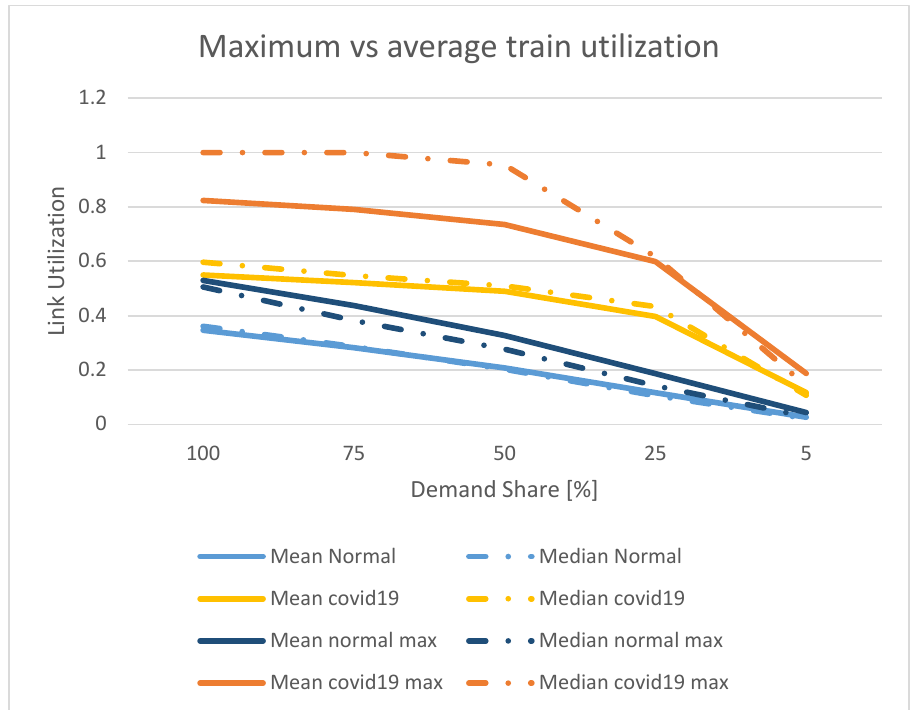
Figure 8. Average vs max train utilization for normal and covid19 conditions